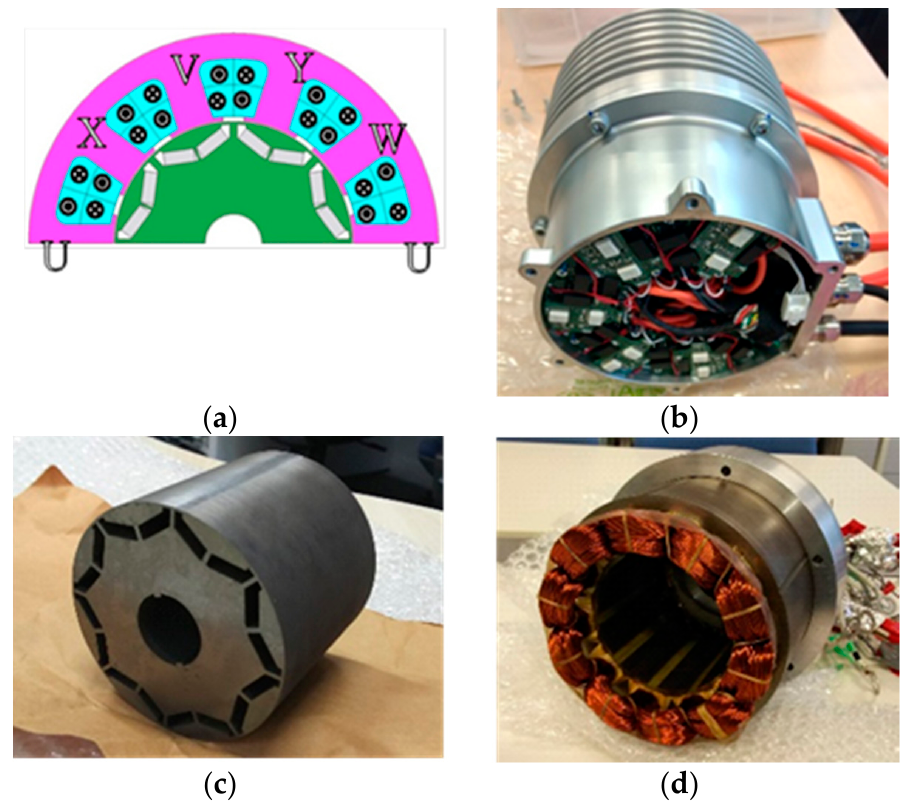
Figure 4. 10 slots 8 poles 5-phase motor model. The rotor was designed to ensure high-speed rotation up to 20,000 rpm. 0.35 mm electrical steel sheet is used and maximum stress at 20,000 rpm is around 100 MPa at the edge of the magnet in the rotor. ( a ) FEA (Finite Element Analysis) 1/2 model of the motor, ( b ) inverter integrated assembled motor, ( c ) rotor without magnet assembly, ( d ) stator with dual windings.